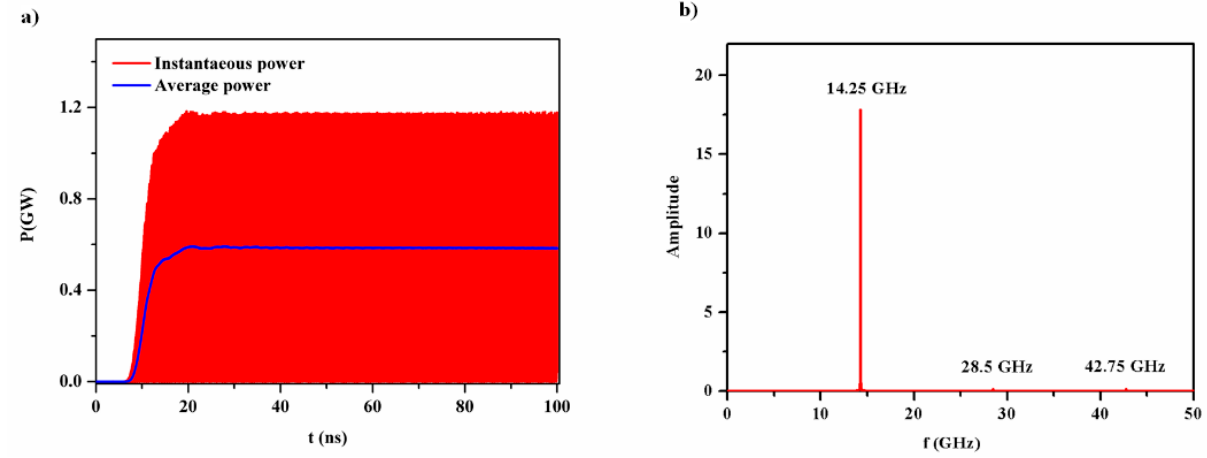
Figure 9. ( a ) Output microwave power versus time. ( b ) Frequency spectrum of output signal.